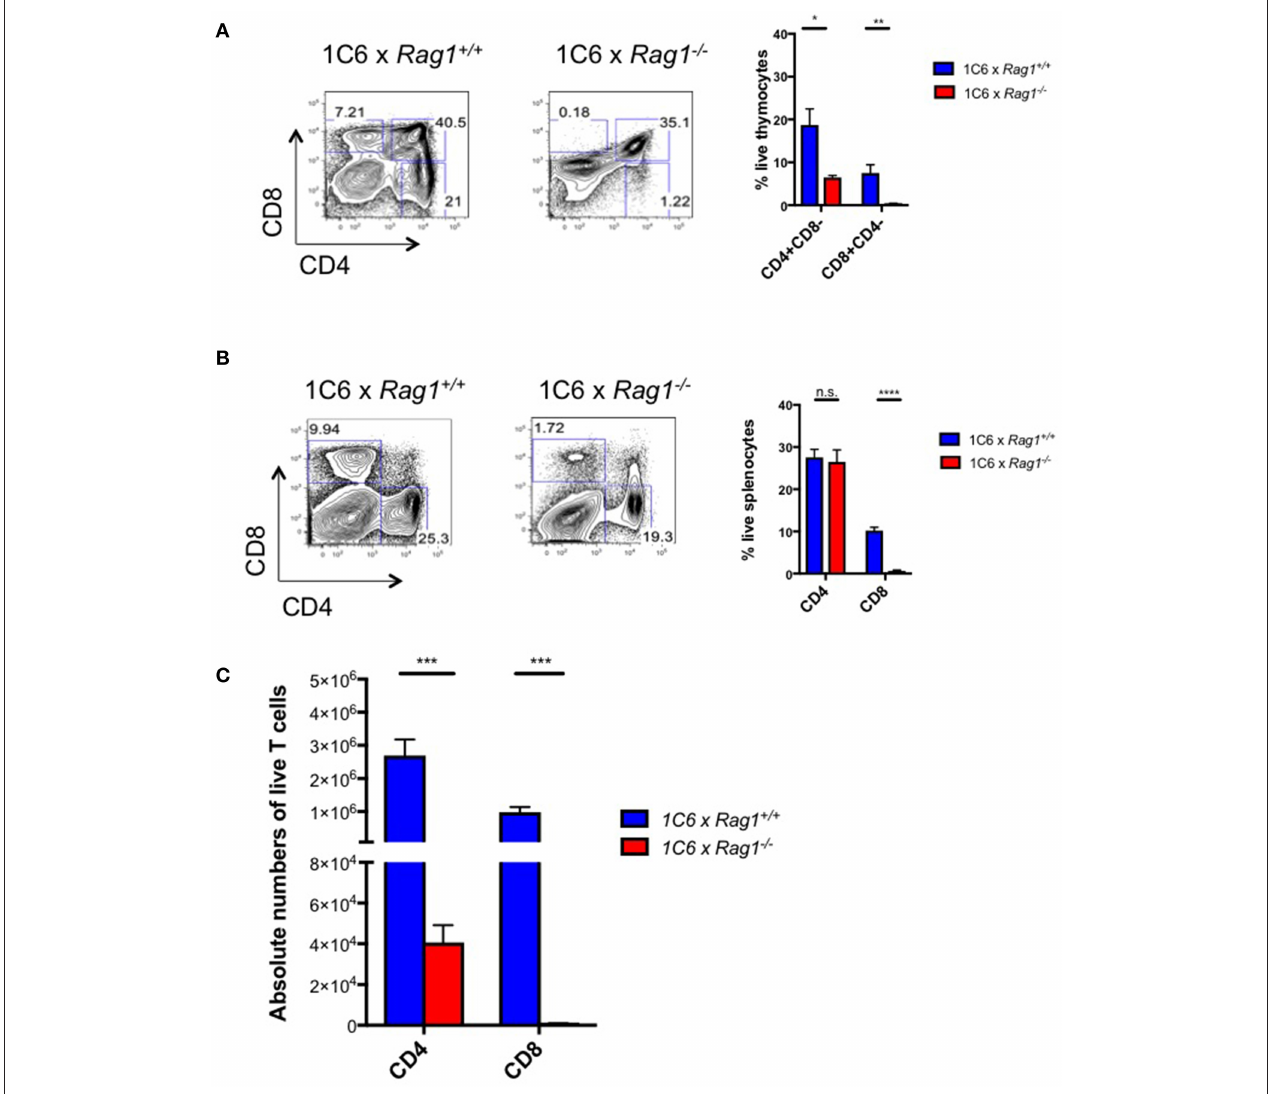
FIGURE 2 | Peripheral T cell populations are dysregulated in 1C6 × Rag1 − / − mice due to defective negative selection. Thymic (A) and splenic (B,C) cell populations were enumerated from female 1C6 ( n = 6) vs. 1C6 × Rag1 − / − ( n = 6) mice. (A) The proportion of thymocytes expressing CD4 and/or CD8 was enumerated. The proportion (B) and absolute frequency (C) of splenic CD4 + and CD8 + T cells were assessed by flow cytometry. Graphs: * p < 0.05; ** p < 0.01; *** p < 0.001; **** p < 0.0001, two-tailed t -test. n.s., not